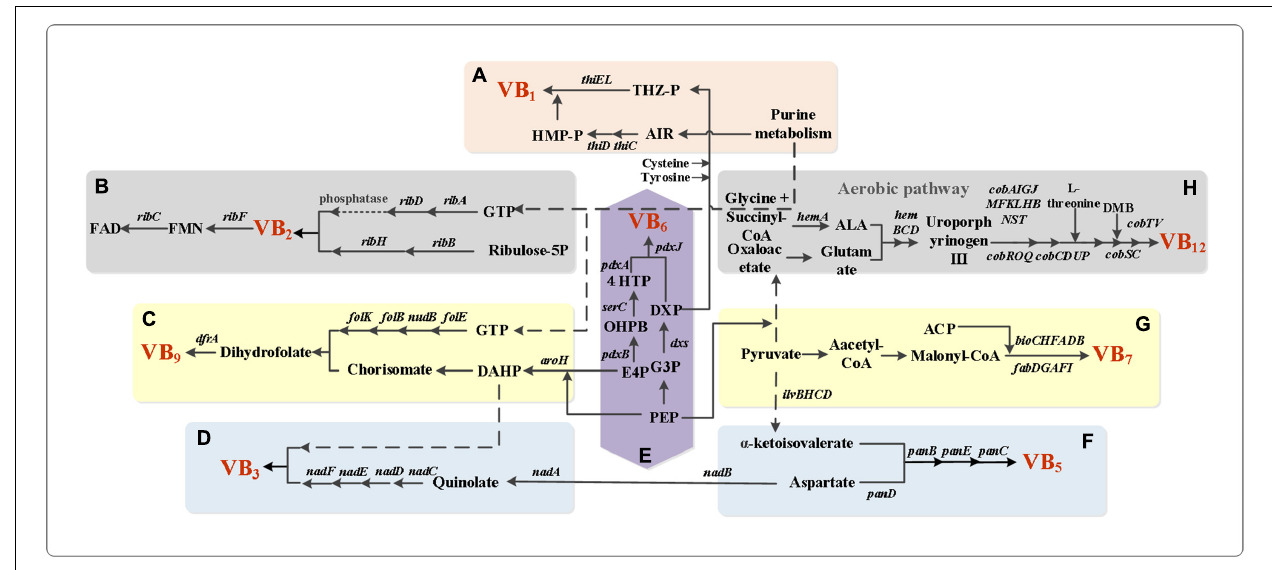
FIGURE 1 | Metabolic network pathway of B vitamins. (A) Biosynthesis pathway of thiamine in E. coli . ThiC/ThiD, phosphomethylpyrimidine synthase; ThiE, thiamine-phosphate pyrophosphorylase; ThiL, thiamine-monophosphate kinase. (B) Biosynthesis pathway of riboflavin in B. subtilis . RibA, GTP cyclohydrolase II; RibB, 3,4-dihydroxy 2-butanone 4-phosphate synthase; RibD, diaminohydroxyphosphoribosylaminopyrimidine deaminase; RibH, 6,7-dimethyl-8-ribityllumazine synthase. RibF, FMN adenylyltransferase; RibC, riboflavin synthase. (C) Vitamin B 9 biosynthesis pathway in B. subtilis . AroH, chorismate mutase; FolE, GTP cyclohydrolase IA; NudB, dihydroneopterin triphosphate diphosphatase; FolB, 7,8-dihydroneopterin aldolase/epimerase/oxygenase; FolK, 2-amino-4-hydroxy-6-hydroxymethyldihydropteridine diphosphokinase; DfrB, dihydrofolate reductase. (D) Vitamin B 3 biosynthesis pathway in E. coli . NadB, L -aspartate oxidase; NadA, quinolinate synthase; NadC, nicotinate-nucleotide pyrophosphorylase; NadD, nicotinate-nucleotide adenylyltransferase; NadE/NadF, NAD + synthase. (E) De novo biosynthesis pathway of vitamin B 6 . PdxB, erythronate-4-phosphate dehydrogenase; SerC, phosphoserine aminotransferase; PdxA, 4-hydroxythreonine-4-phosphate dehydrogenase; PdxJ, pyridoxine 5-phosphate synthase; Dxs, 1-deoxy- D -xylulose-5-phosphate synthase. (F) Pathway for de novo synthesis of vitamin B 5 . ilvBHCD , increased the transcription levels of the ilv genes; panDBEC , pantothenate biosynthetic genes. (G) Biosynthesis pathway of Vitamin B 7 in E. coli . BioC, malonyl-CoA O -methyltransferase; BioH, pimeloyl-[acyl-carrier protein] methyl ester esterase; BioF, 8-amino-7-oxononanoate synthase; BioA, 8-amino-7-oxononanoate aminotransferase; BioD, dethiobiotin synthetase; BioB, biotin synthase; FabD, S -malonyltransferase; FabG,